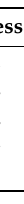
Table 2. Vickers micro-hardness of the dental implant drills examined. The values are those typical of steel employed to make surgical drills [32].